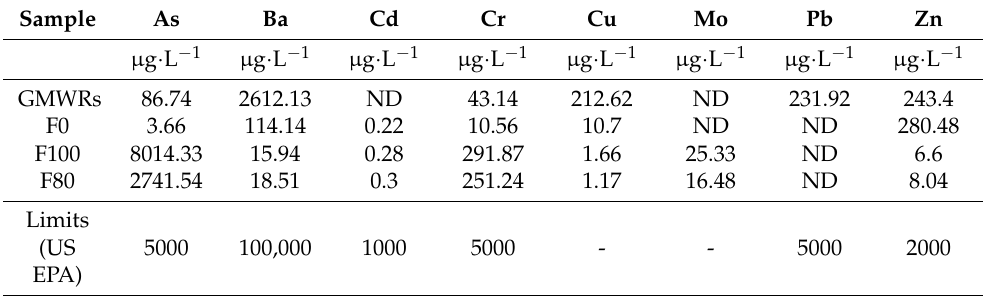
Table 3. Results of TCLP test of GMWR raw material and F0, F100 and F80 fired bricks at 1050 ◦ C.